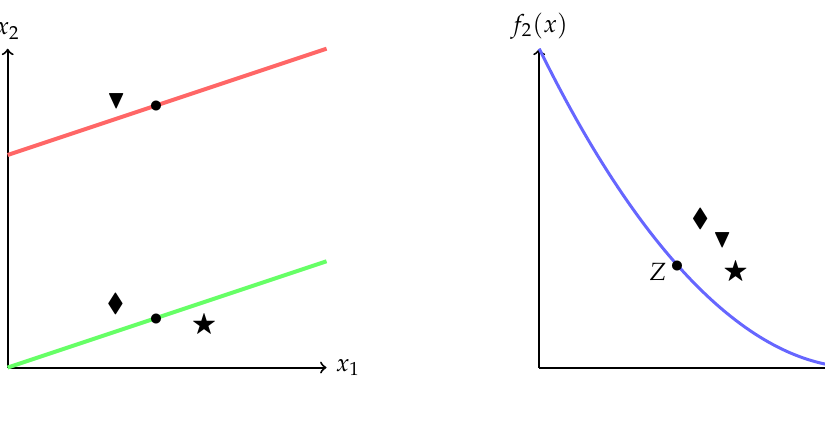
Figure 3. Illustrative